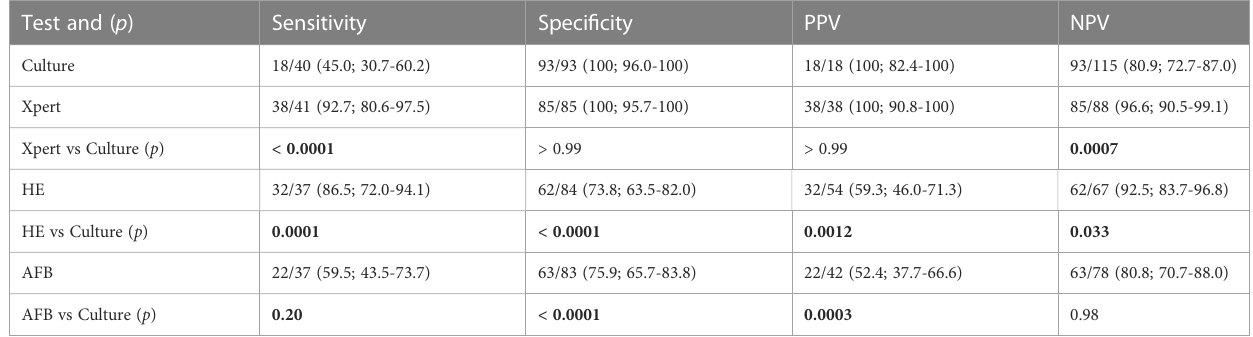
TABLE 4 Culture, Xpert, HE, and AFB diagnostic accuracy in smear-negative biopsy samples. Test and ( p